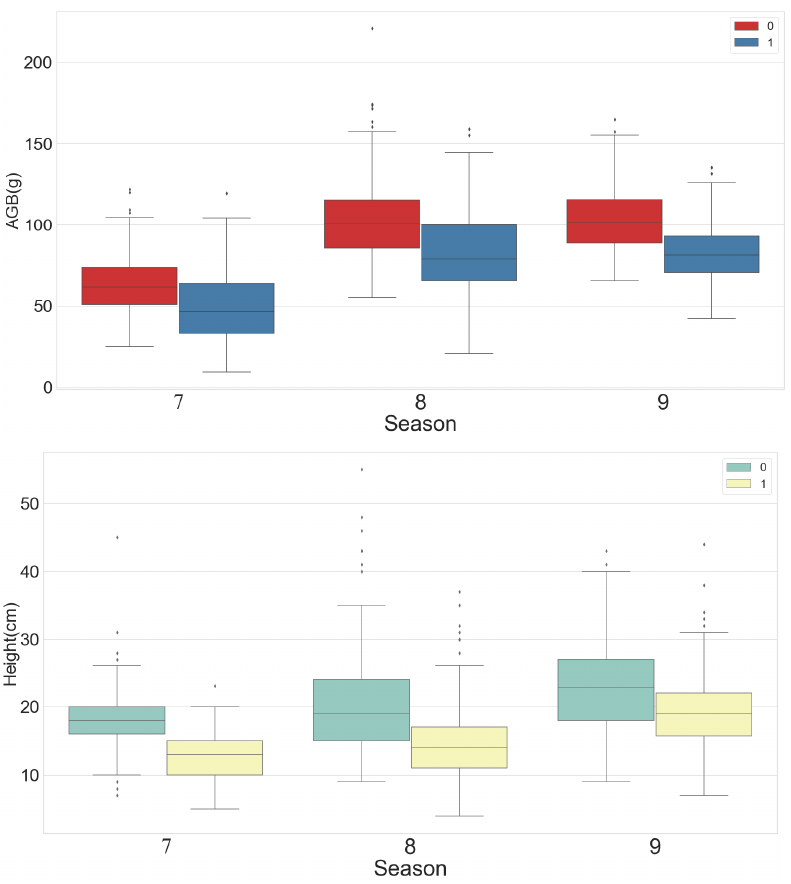
Figure 6. Box plots showing statistical analysis of AGB and grass height by month (7 = July, 8 = August, 9 = September). Numbers 0 and 1 indicate not grazed and grazed. 8 = August, 9 = September). Numbers 0 and 1 indicate not grazed and